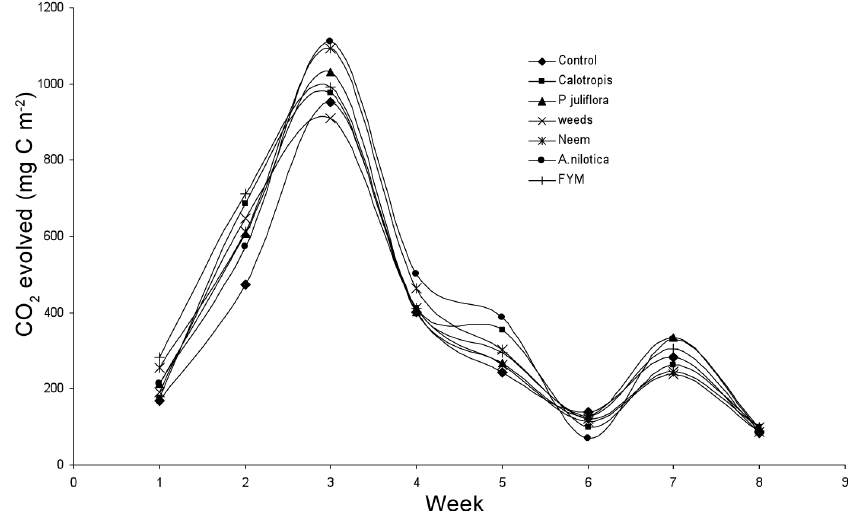
Figure 3. Carbon dioxide evolution from compost amended ( Calotropis procera , Prosopis juliflora , weeds, Azadirachta indica and Acacia nilotica ) and unamended plots at various sampling dates.